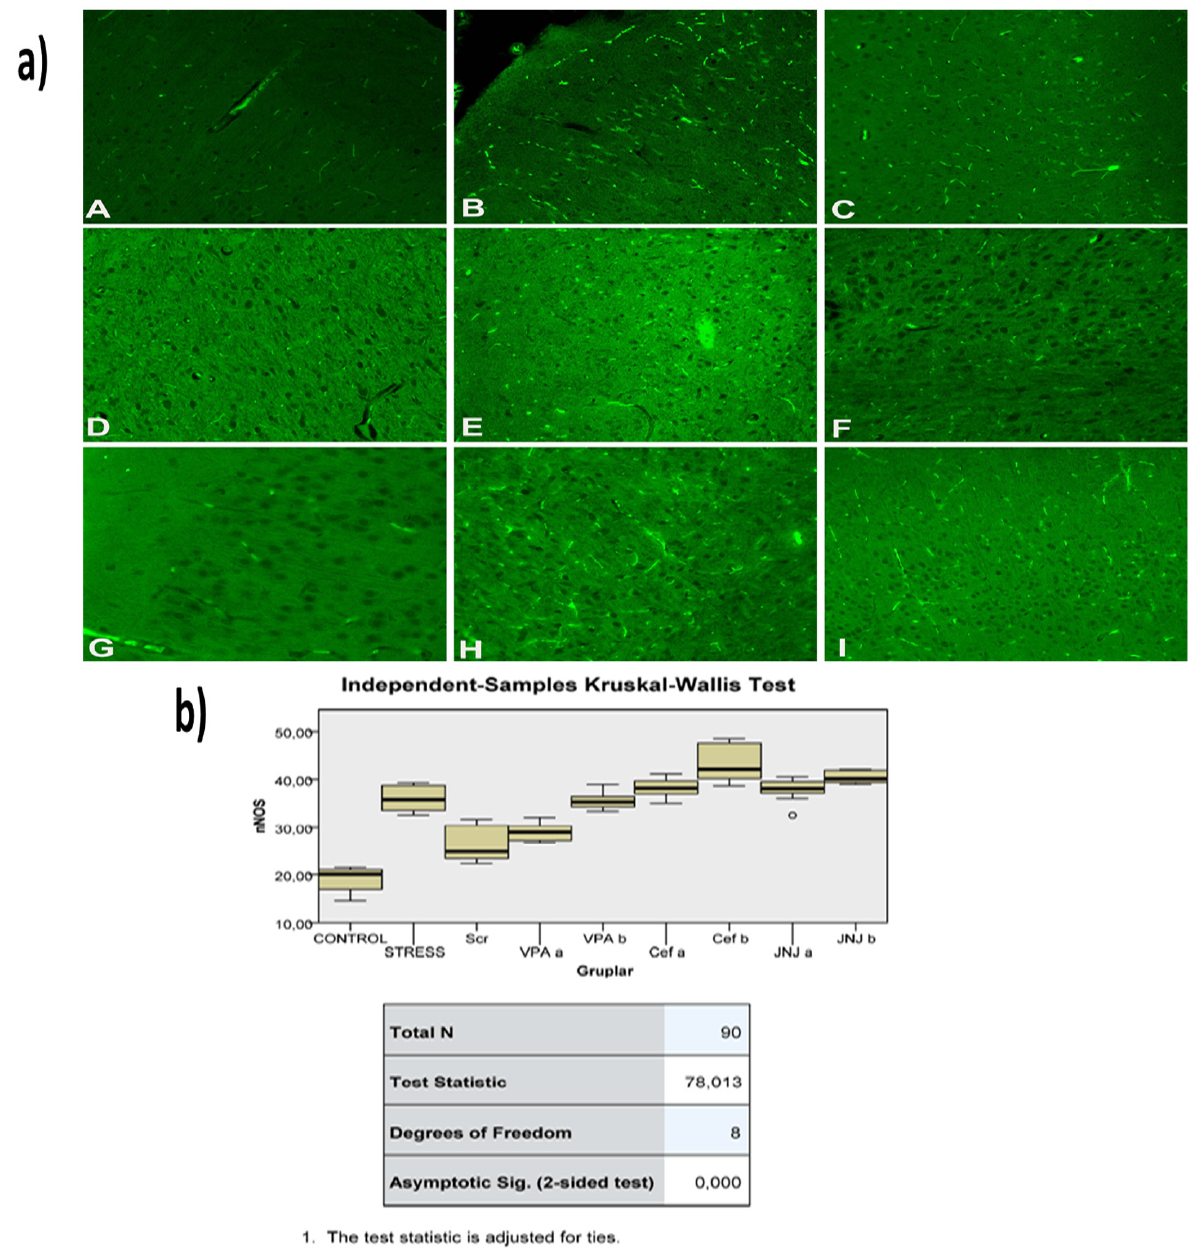
Figure 9. ( a ) nNOS images of experimental groups. Histopathological images of A (Control), B (Stress), C (Ser), D (VPAa), E (VPAb), F (Cefa), G(Cefb), H (JNJa), and I (JNJb). IHC-P—immunohistochemistry-paraffin protocol; IF—immunofluorescent staining. ( b ) Quantitative analysis of IHC, immunofluorescence staining, and mean immunoreactivity intensity was determined using ImageJ software (ImageJ). p < 0.05 was considered statistically significant.